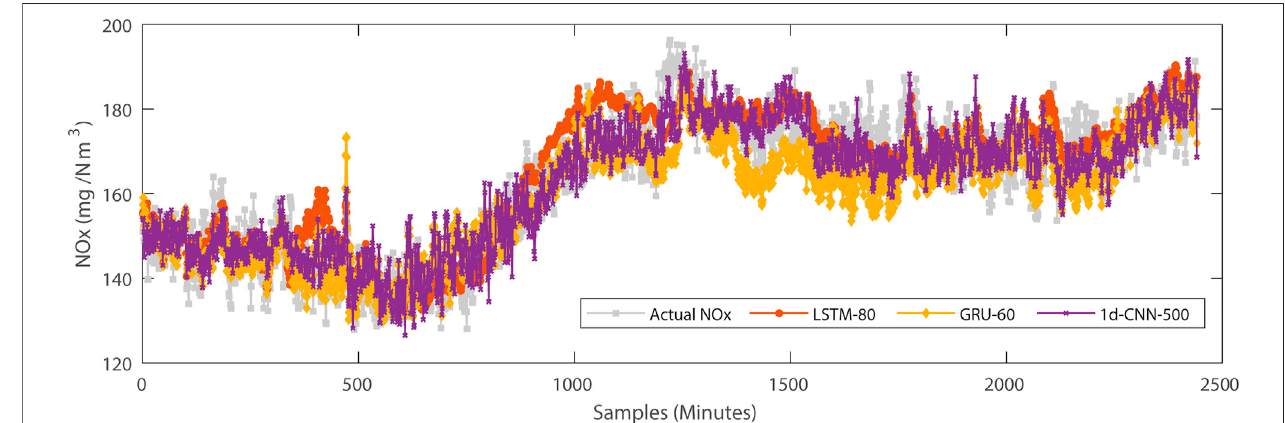
FIGURE 10 | Testing data NOx prediction performance comparison of DNN techniques.